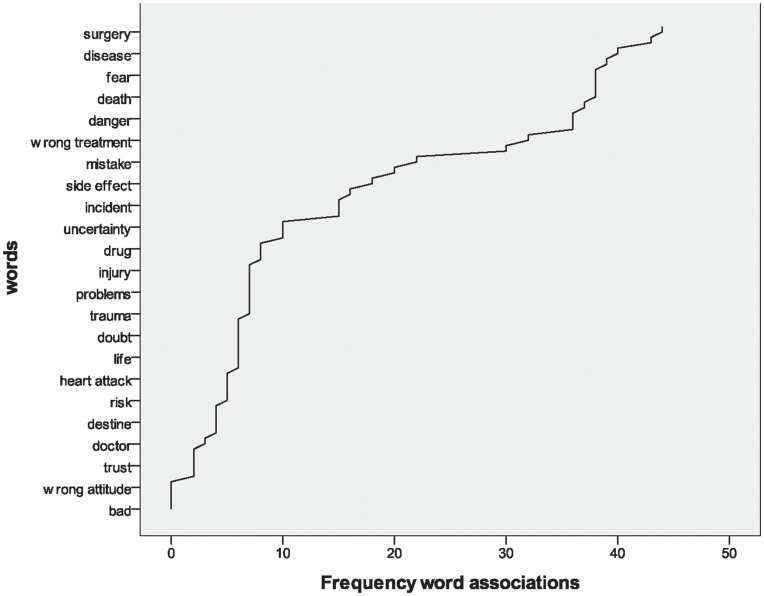
Diagnostic Box-Plot.